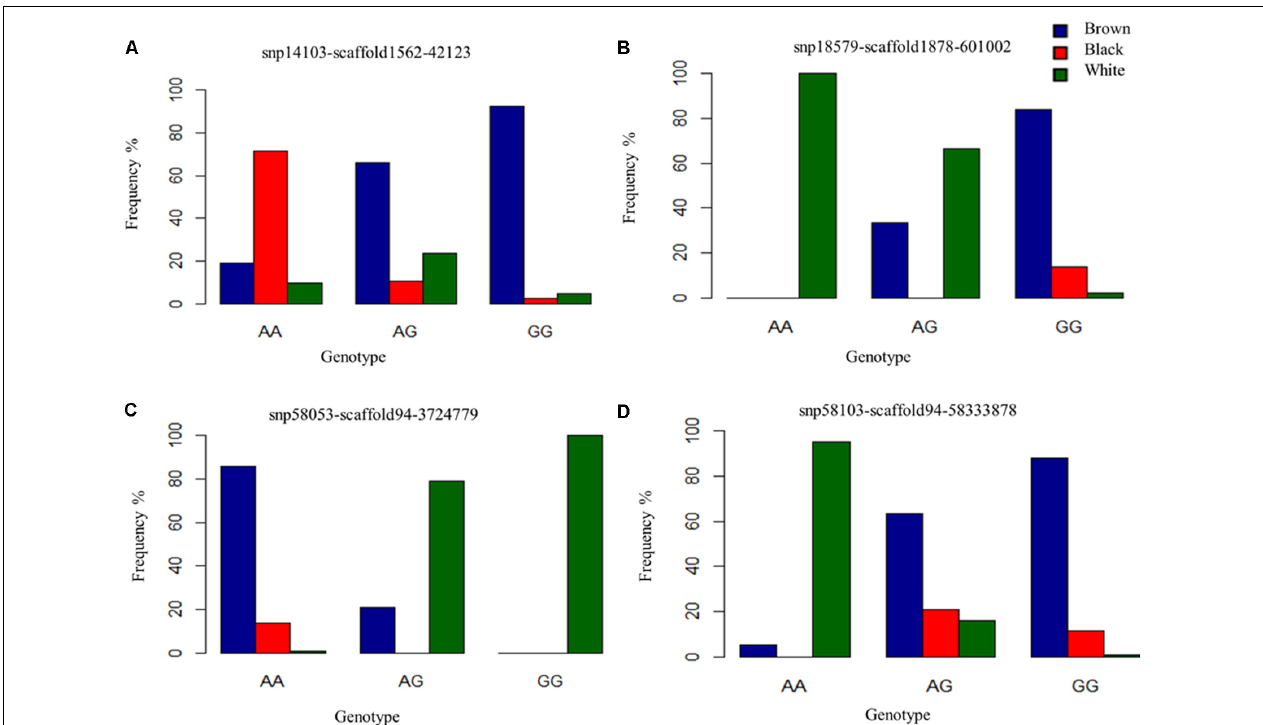
FIGURE 5 | Genotype frequencies of prominently associated SNPs for each coat color. (A) Identifies a commonly associated SNP for black and brown coat color demonstrating variation in genotypic frequency. (B–D) Depict genotypic frequency distribution for three SNPs associated with white coat color.